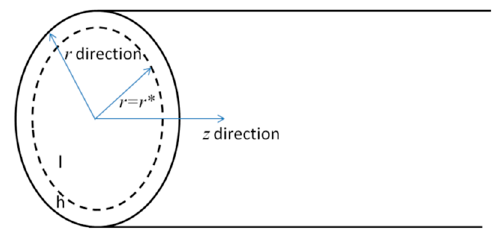
Figure 1. Coordinate system used for modelling EOF in each single pore of porous polymer membrane.